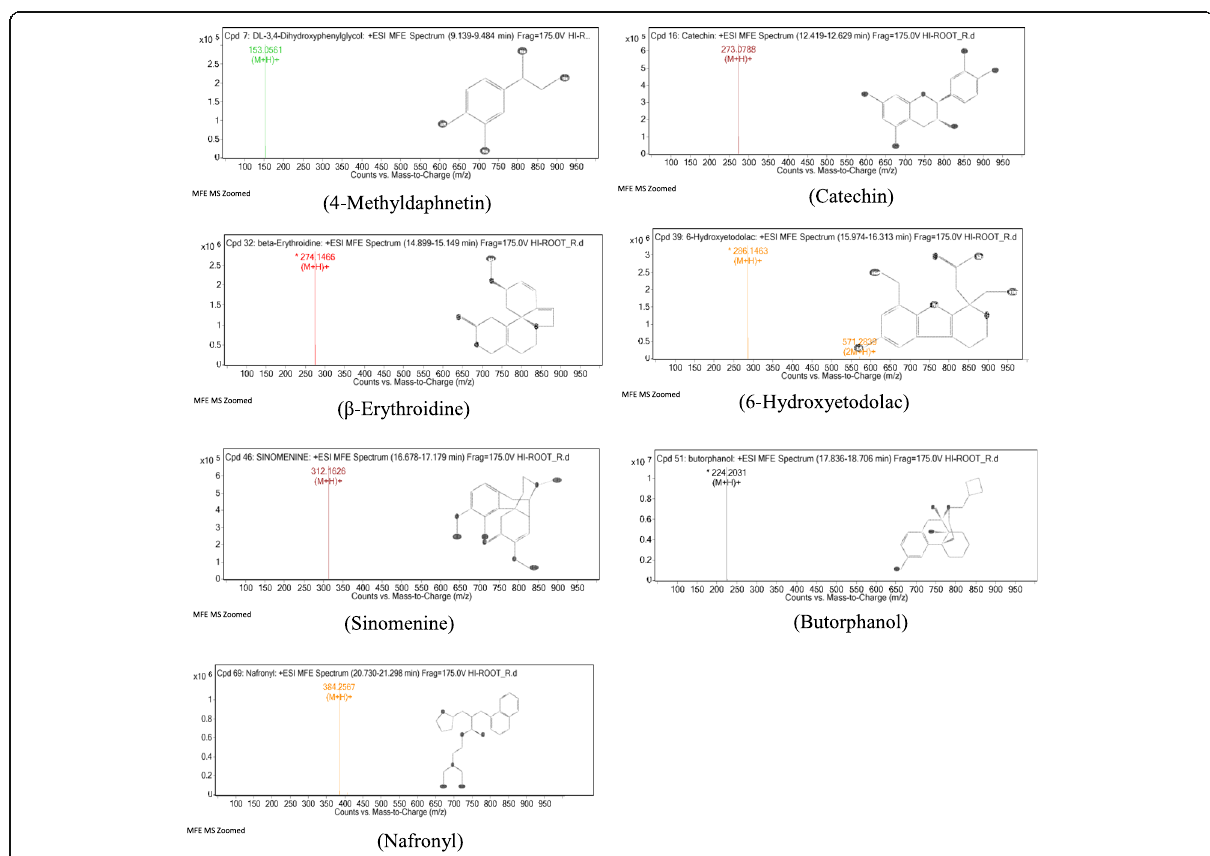
Fig. 2 MFE MS Spectrum of some compounds of HIE detected by